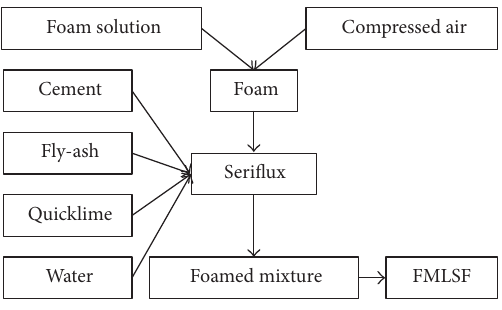
Figure 2: The specimen preparation process.